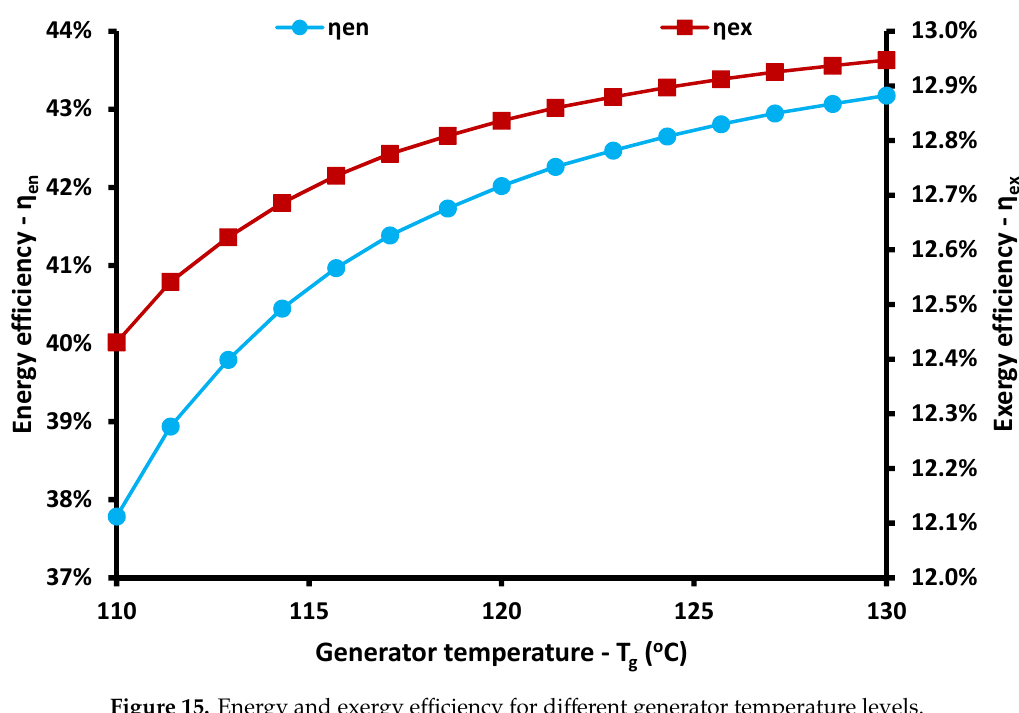
Figure 15. Energy and exergy efficiency for different generator temperature levels.